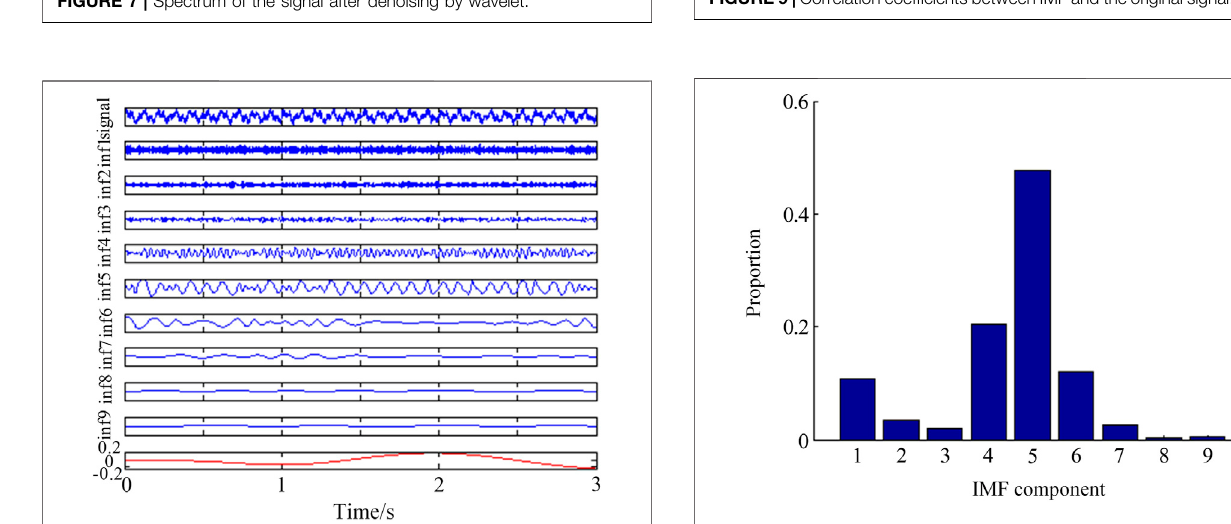
FIGURE 9 | Correlation coef fi cients between IMF and the original signal.